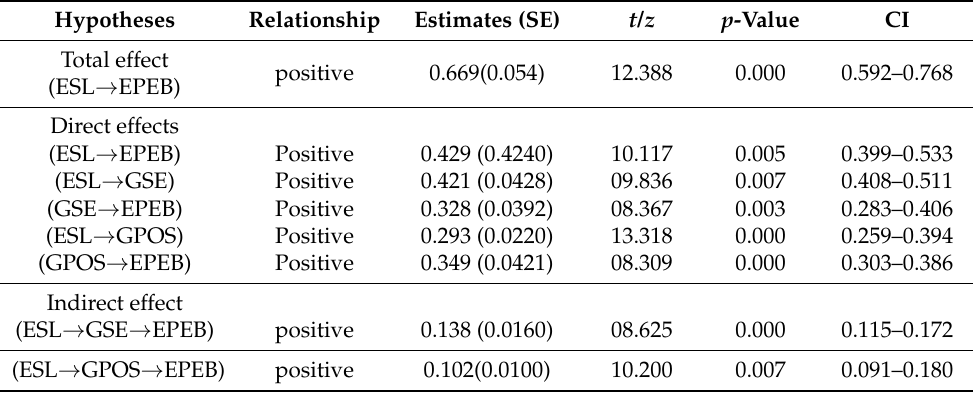
Table 3. Total, direct, indirect, and conditional